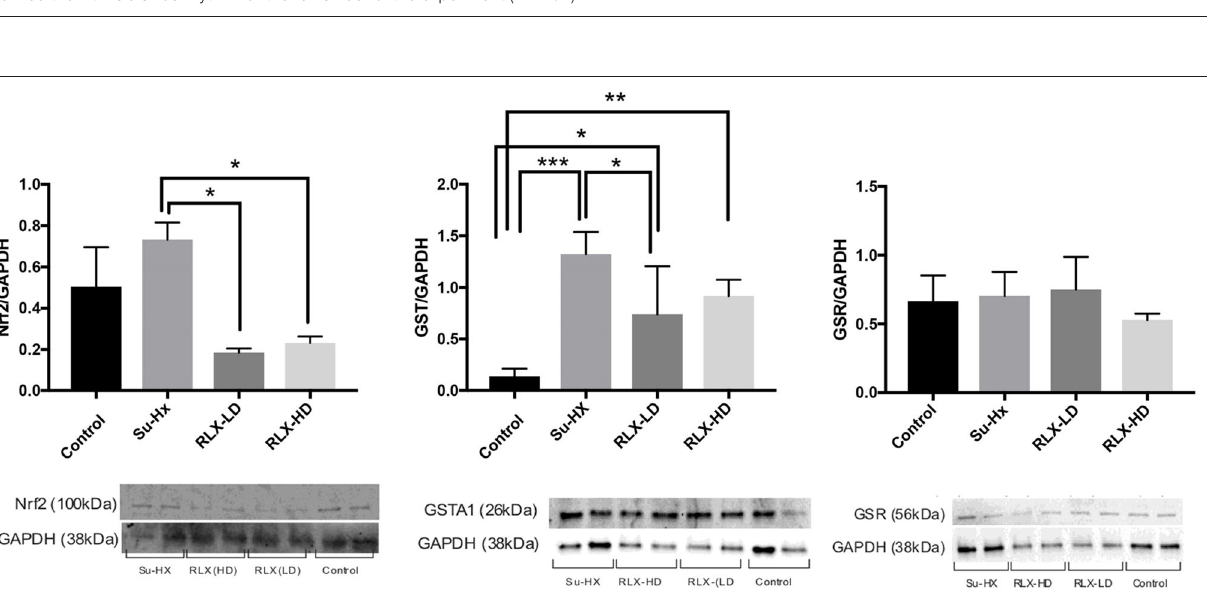
Frontiers in Cardiovascular Medicine |